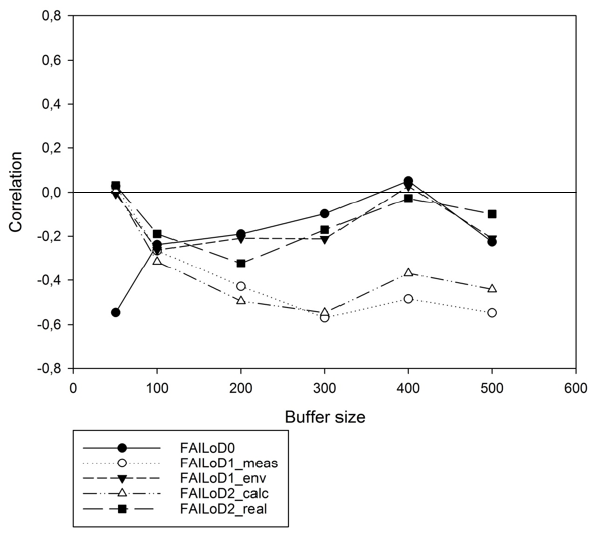
Figure 12. Correlation coefficient of the ‘frontal area index’ from LoD0 (FAILoD0), LoD1 with different height measures (FAILoD1_meas, FAILoD1_env, FAILoD2_calc) and LoD2 (FAILoD2_real) with measured TNC values in different buffer sizes.